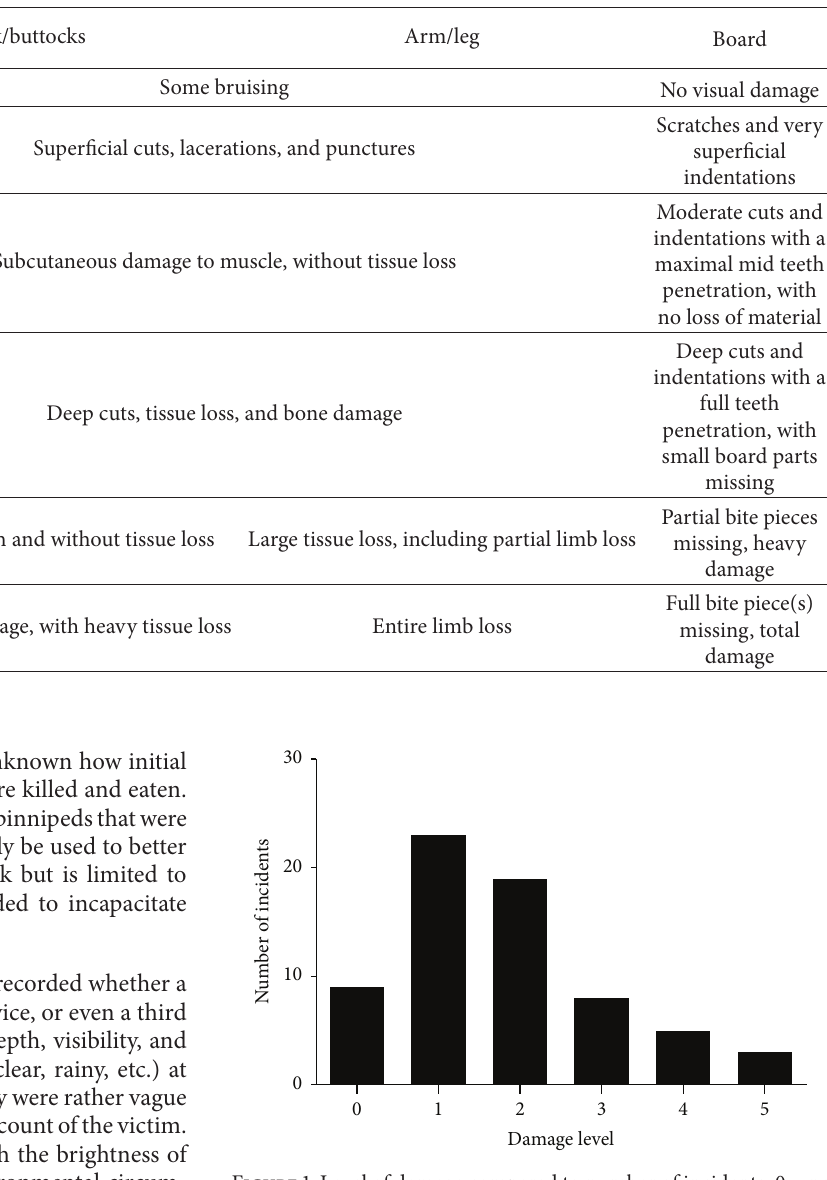
Figure 1: Level of damage compared to number of incidents. 0 = no damage to body and board; 1 = minor; 2 = moderate; 3 = serious; 4 = severe; 5 =